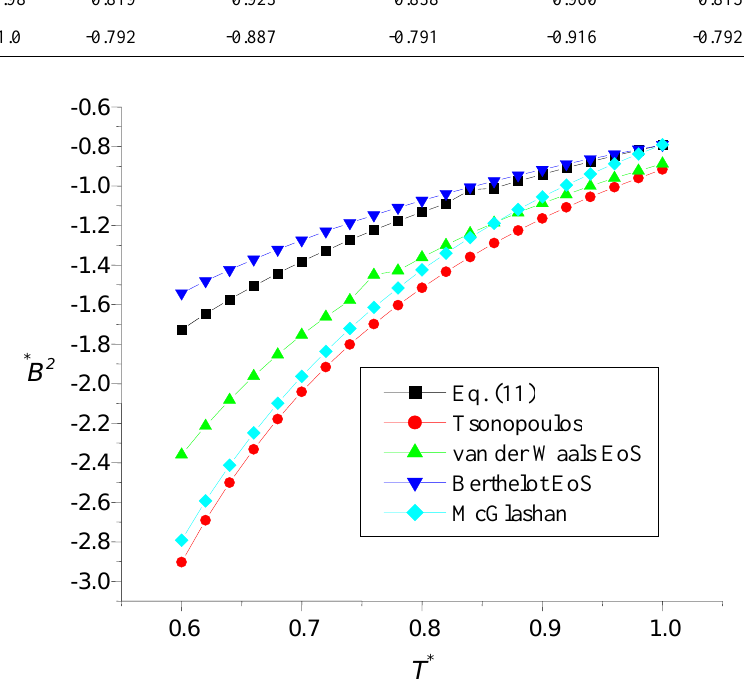
Figure 2. Second virial coefficient of